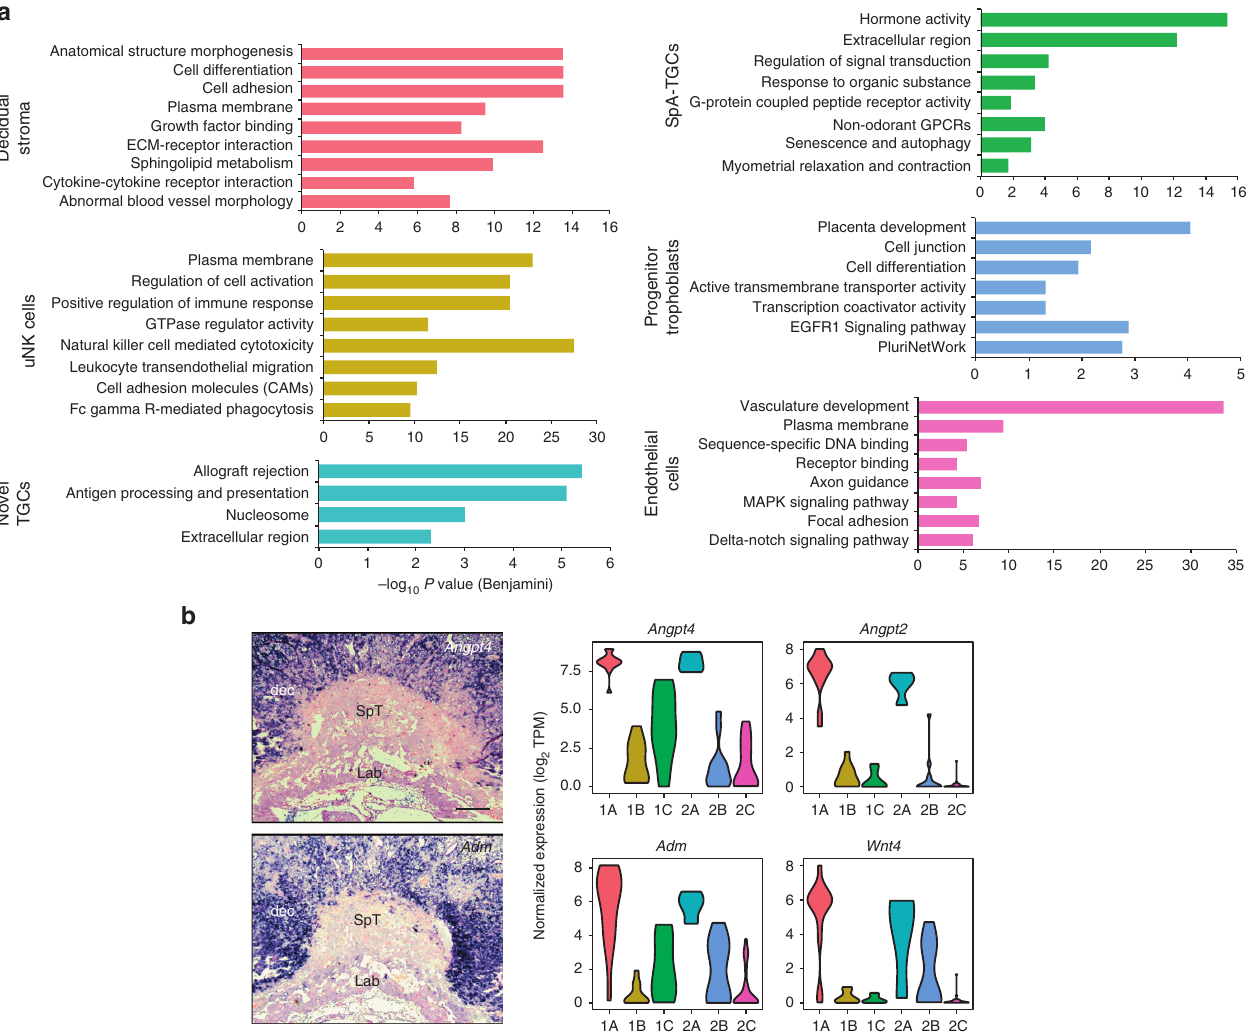
Figure 6 | Functional annotation analysis reveals discrete activities of each cell type. ( a ) Functional annotation of genes corresponding to each of the groups as indicated in Figure 2c. the selected Gene Ontology, KEGG Pathway, Wikipathway and MGI phenotype terms are shown. Benjamini and Hochberg corrected –log 10 P value from hypergeometric test is reported. ( b ) Decidual stromal cells express high levels of secreted factors regulating vascular fates. Bar, 200 m